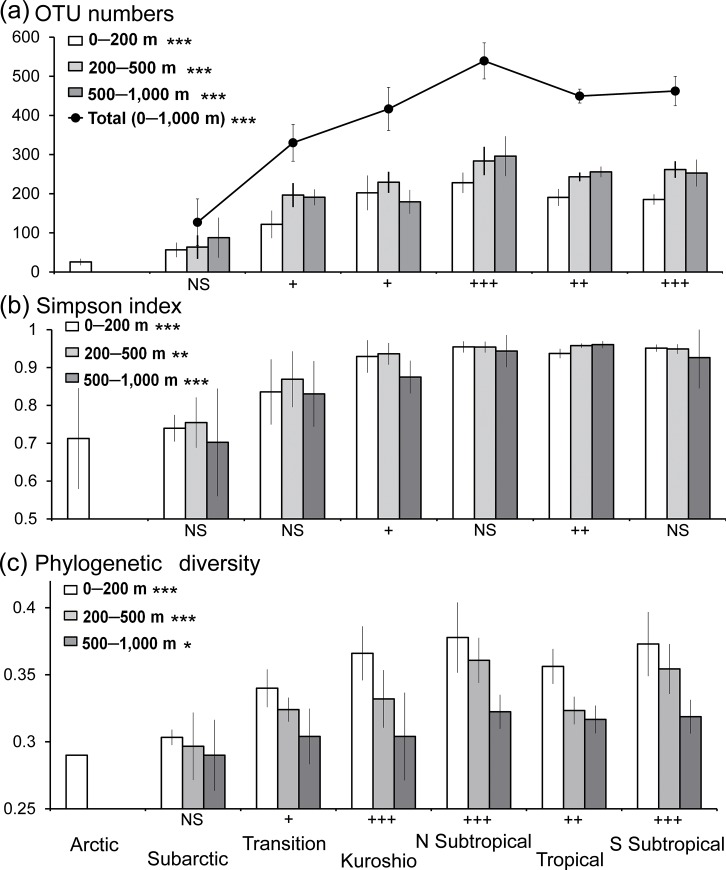
Horizontal and vertical patterns of copepod diversity.(a) Number of operational taxonomic units (OTUs). (b) Simpson diversity index. (c) Phylogenetic diversity. The California Current region is included in Transition region. The diversity parameters were averaged for each region and scale bars indicate standard deviation. NS = not significant; * = P < 0.05; ** = P < 0.005; *** = P < 0.001 based on Kruskal-Wallis tests among geographic regions; + = P < 0.05; ++ = P < 0.005; +++ = P < 0.001 based on Kruskal–Wallis tests among sampling depths. Details of the statistical analyses are listed in S5 Table. Maps were created by the authors in Generic Mapping Tools version 5 [30].